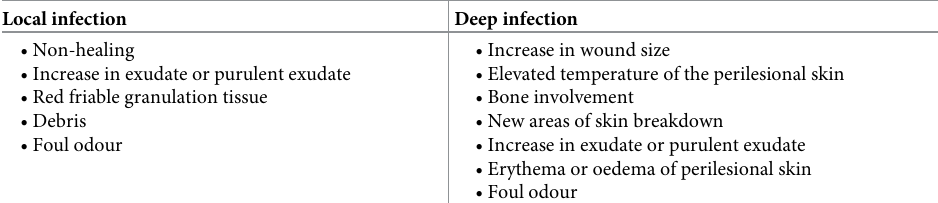
Table 2. Clinical criteria for local and deep secondary bacterial